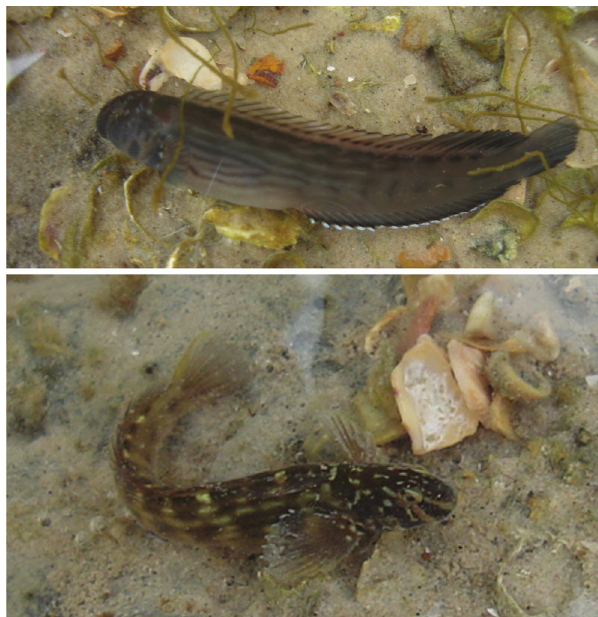
Fig. 1. Omobranchus punctatus in natural habitat (tide pools) in Brazil. Photos by J.